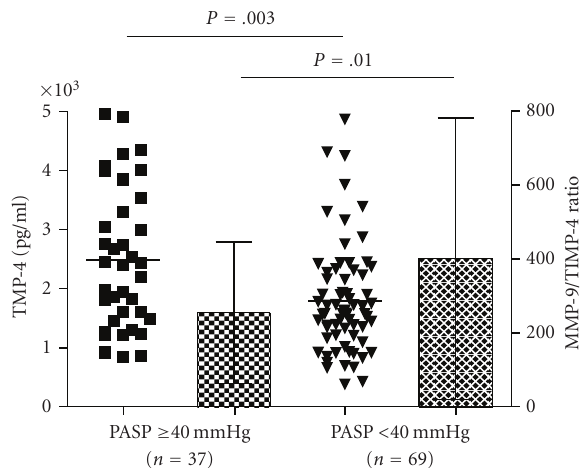
Figure 2: Patients with SSc and elevated pulmonary artery systolic pressure (PASP ≥ 40 mmHg) have higher TIMP-4 levels and smaller MMP-9/TIMP-4 ratios (bars show SD) than the remaining patients (Mann-Whitney